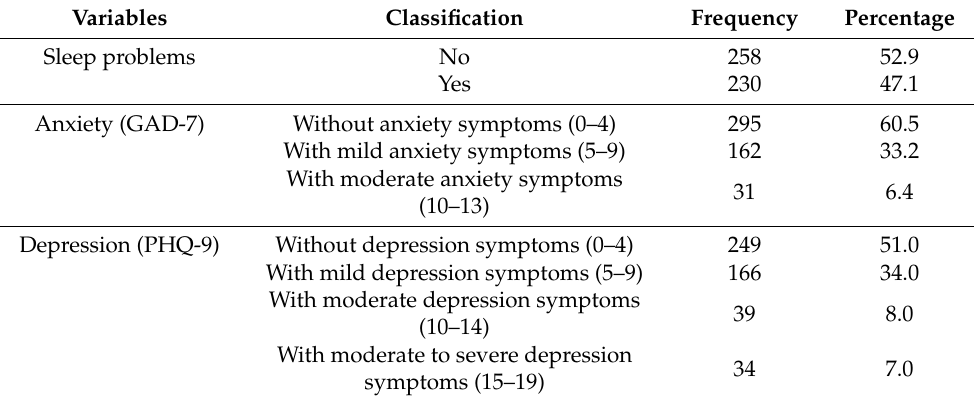
Table 2. Prevalence of sleep problems, anxiety, and depression among international students during the COVID-19 ( N =